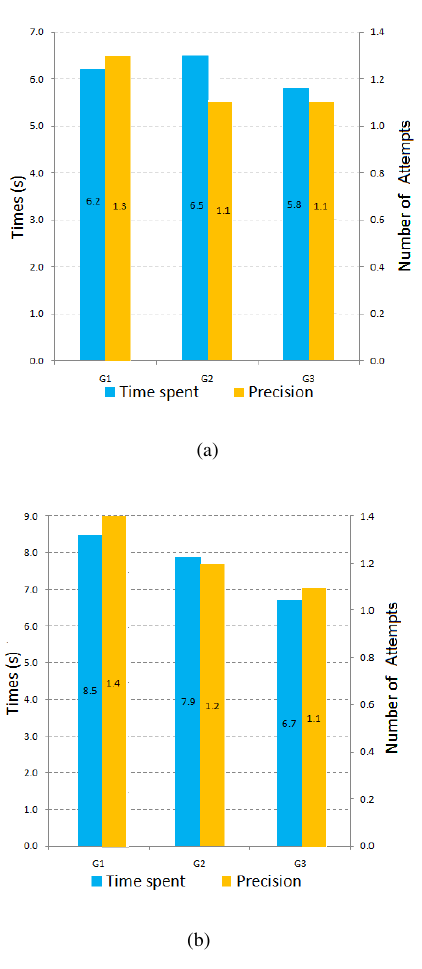
Fig. 16: In (a) and (b), the general performance of 2D images and 3D models (time spent and precision) per group of participants, respectively.